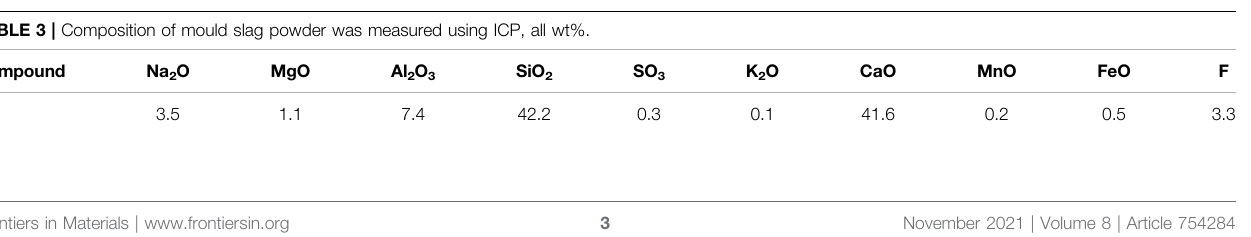
TABLE 2 | Composition of the iron powder as provided by BASF measured using ICP, all wt. %. Element Fe C Wt%